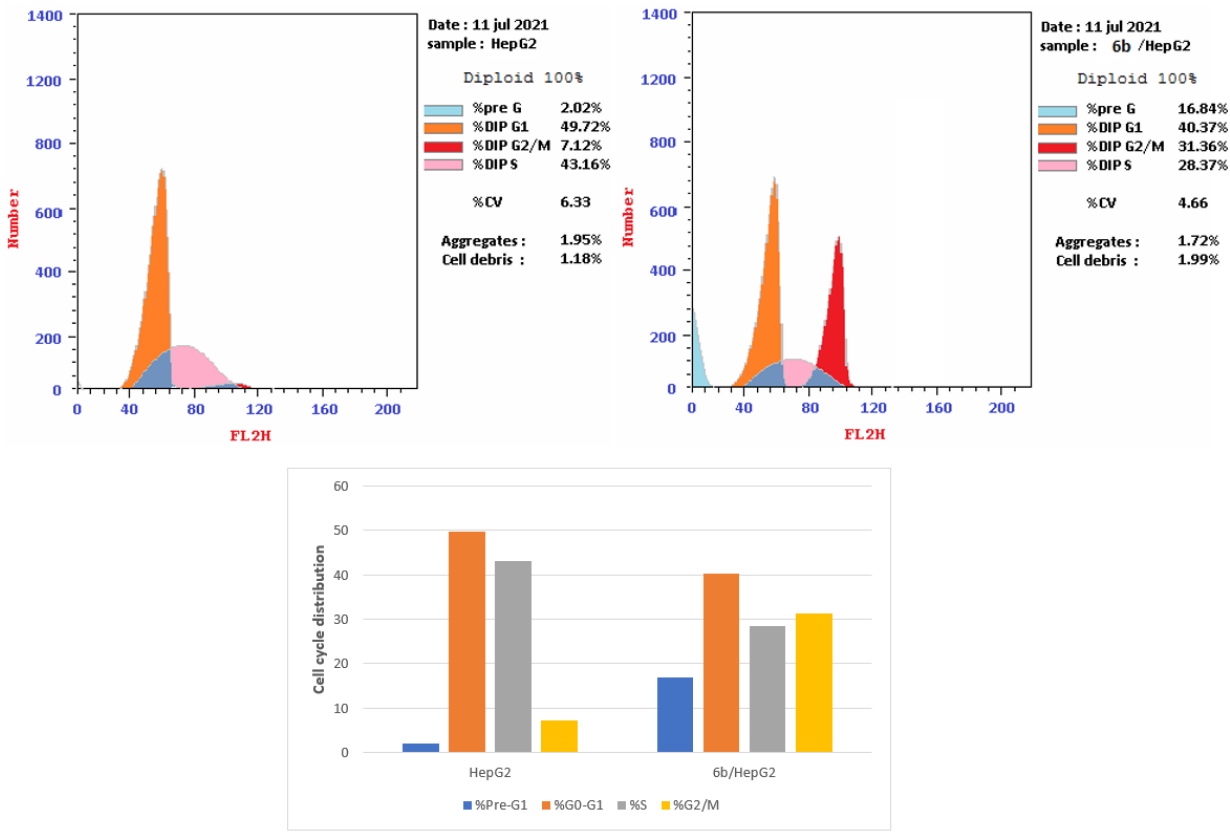
Figure 5. The cell cycle analysis of HepG2 cells treated with compound 6b for 24 h, using flow cytometry.